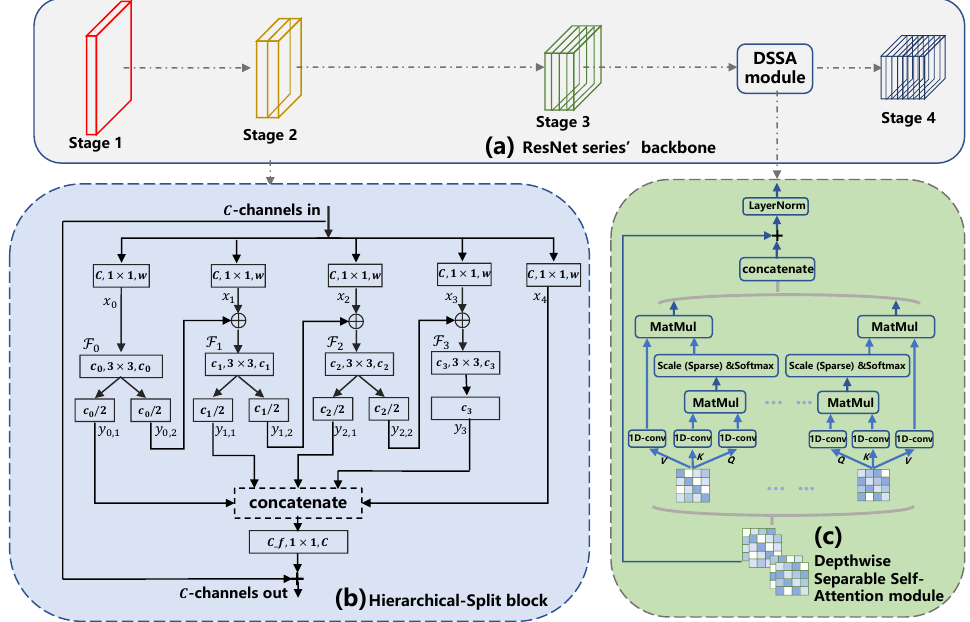
Figure 3. Detail structure of HS-ResNet50 and Depthwise Separable Self-Attention module for the combined